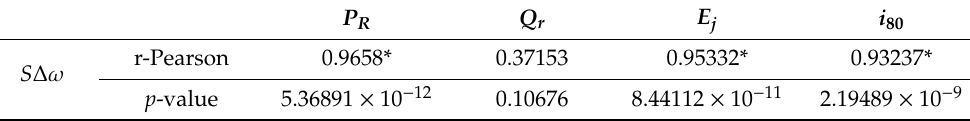
Table A5. Results of the analysis of variable correlation using the Pearson method for the process of rice